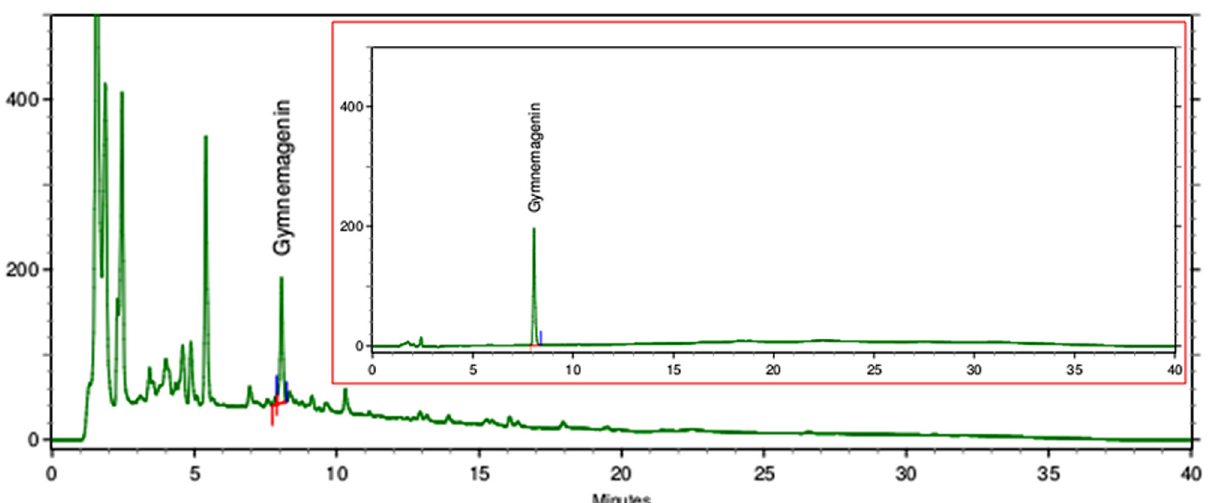
Fig 4. HPLC chromatograms of Gymnema sylvestre leaf extract and reference standard, gymnemagenin, as insert within image.